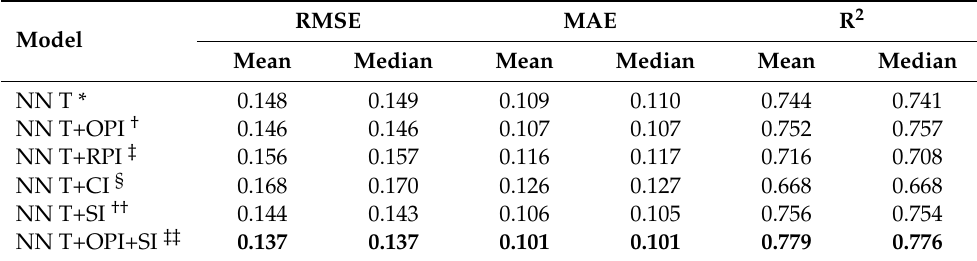
Table 4. Cross-validated performances on 10